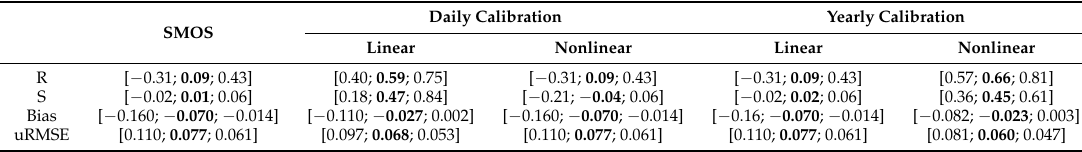
Table 3. Same as Table 2, but for Urgell 2015. Daily Calibration Yearly Calibration SMOS Linear Nonlinear Linear